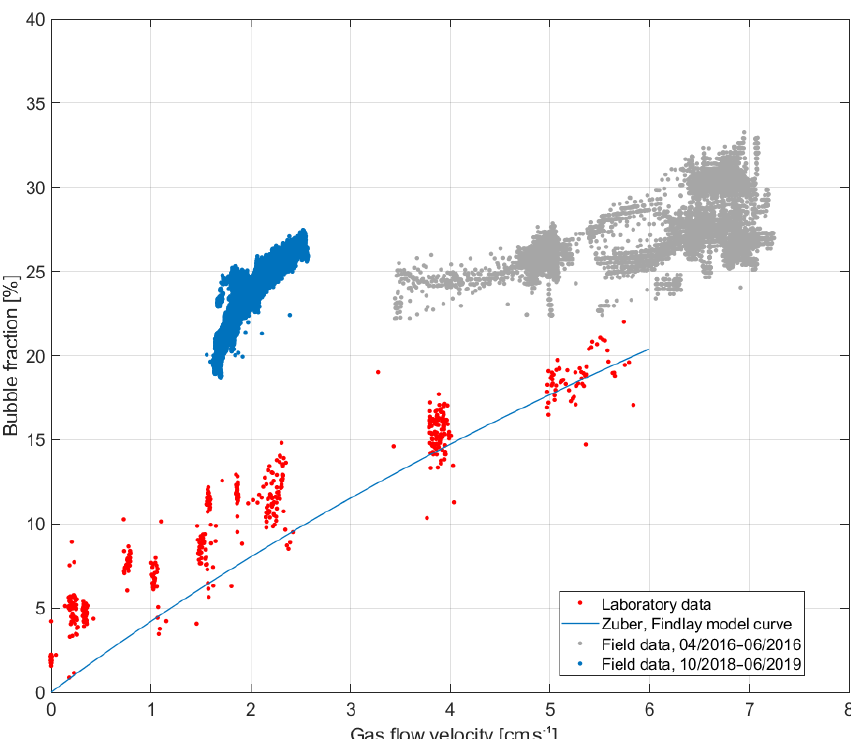
Figure 5. Comparison of gas flow velocity and volumetric fraction of bubbles for the field (Hartoušov mofette) and laboratory measurement. Laboratory measurements are smoothed by RC circuit of 30s time constant (red points) and additionally by running average of 1min length; the field measurements from 2016 (grey points) are based on the differential method with sensor distance of 1.0m; the field measurements from 2018 to 2019 (blue points) are based on the integral method. Blue line is the best fit based on Eq.